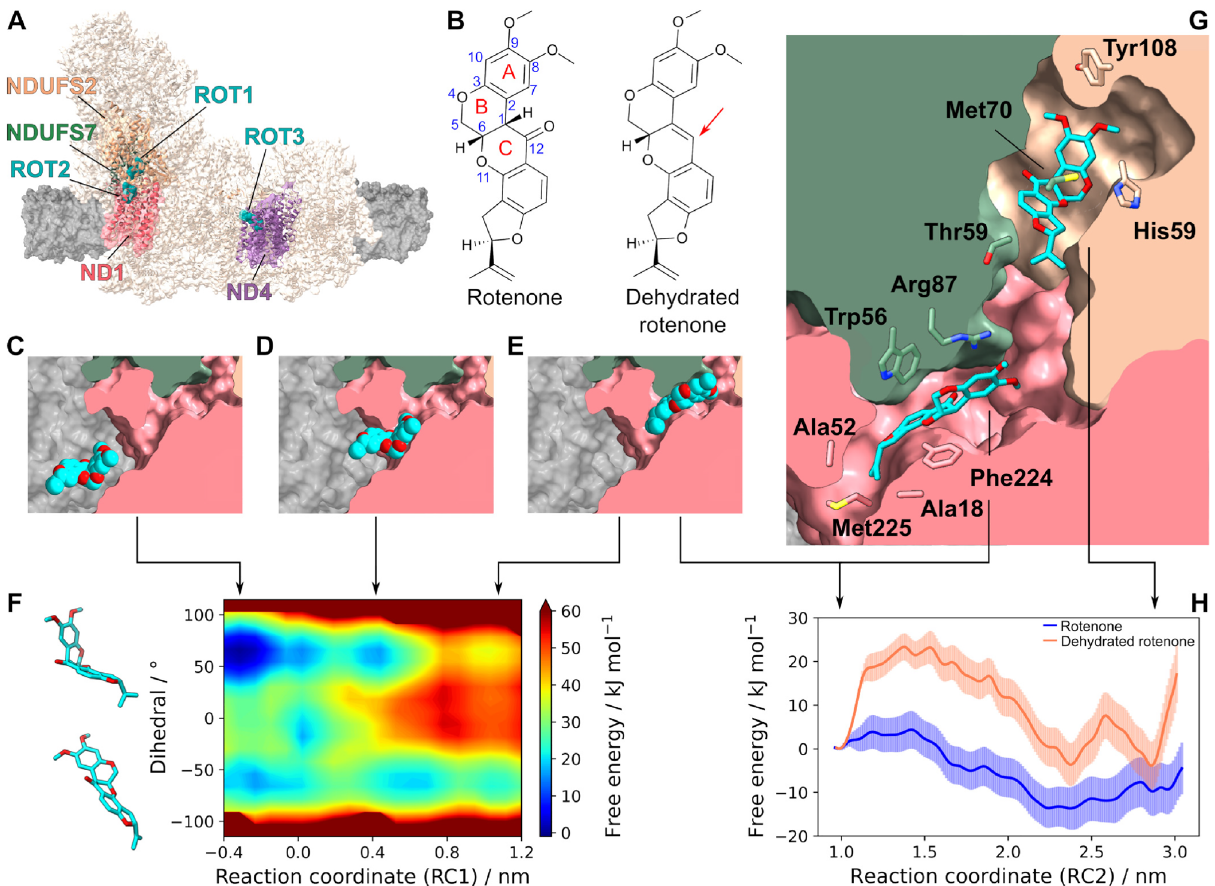
Figure 1. Mechanism of rotenone binding into respiratory complex I. ( A ) Structure of complex I is shown with subunits ND1, ND4, NDUFS2 and NDUFS7 colored respectively in pink, purple, peach and green, with the membrane in gray. Three rotenone binding modes (ROT1, ROT2 and ROT3) observed in cryoEM models 8,9 are displayed in cyan spheres. ( B ) Chemical structures of rotenone (left) and dehydrated rotenone (right), with a red arrow indicating C1 = C12 double bonding. Rotenone is shown in cyan (carbon) and red (oxygen) spheres on the ( C ) membrane, ( D ) narrow entrance and ( E ) ROT2 binding mode along the entry process. ( F ) Two-dimensional free energy profile for the entry process (corresponding to panels C → D → E ). Rotenone structures in bent (dihedral χ 2 ≈ + 65 ◦ ) and straight ( χ 2 ≈ − 65 ◦ ) conformations are shown on the left. ( G ) The Q-channel, with rotenone in binding modes ROT2 and ROT1. Two molecules are displayed here for visualisation, but only one was present during simulations. ( H ) Free energy profile for ligand transit from channel central region (ROT2) to Q-redox site (ROT1) for rotenone (blue) and dehydrated rotenone (orange). Uncertainties are shown in colored shadows. Arrows from panels ( C – E and G point to the corresponding reaction coordinate in panels ( F ) (RC1) and ( H )